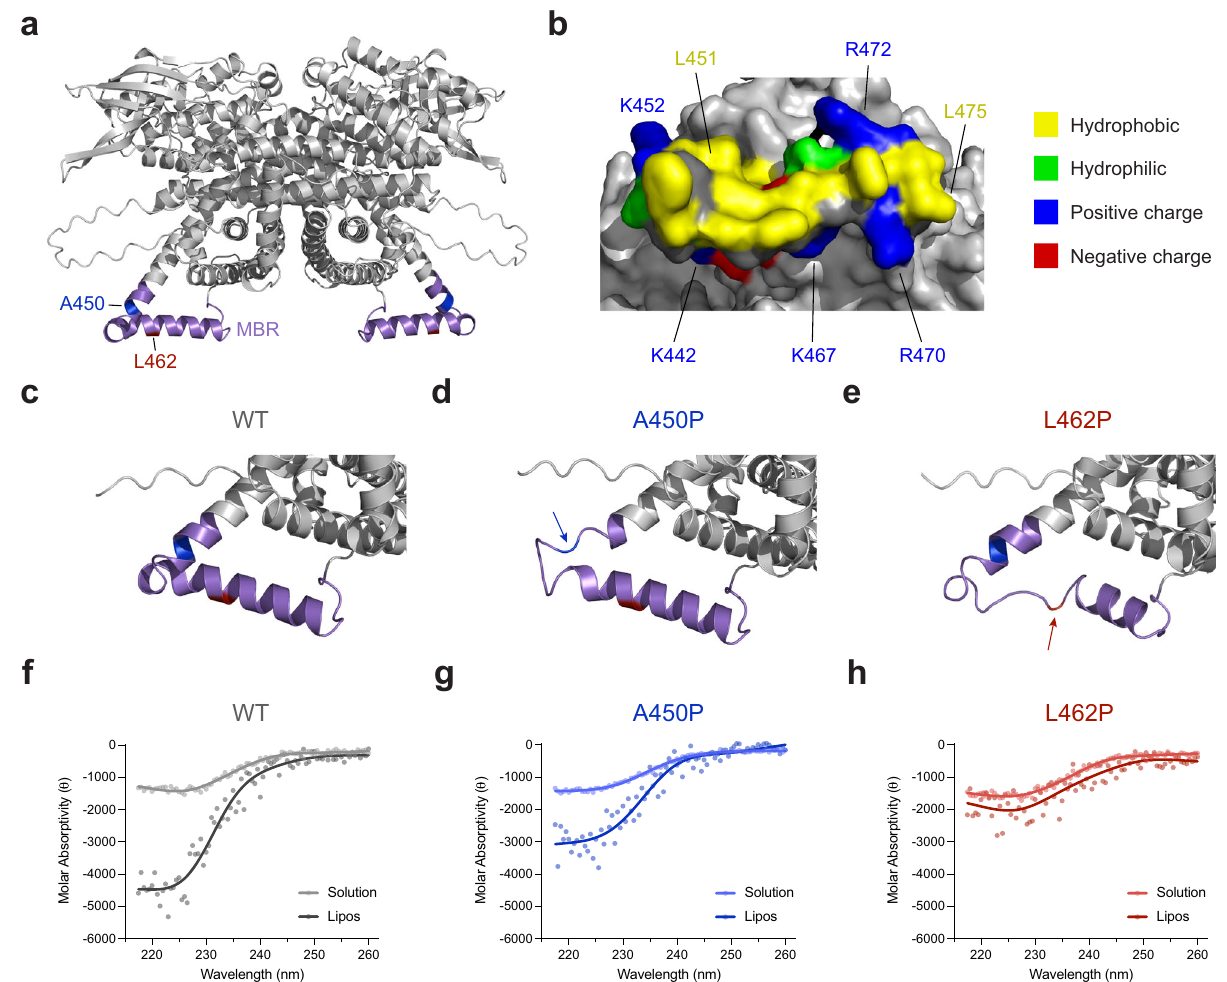
Fig. 4 Computational and circular dichroism analyses support a model for proline-mediated disruption of a membrane-interacting hairpin located within VLCAD ’ s C-terminal domain. a AlphaFold model structure of dimeric VLCAD demonstrating residues 440 – 473 as a helix-turn-helix hairpin. Residues A450 and L462, two sites of proline mutagenesis in human VLCAD de fi ciency, are colored in blue and red, respectively. b A surface view of the predicted α -helical hairpin demonstrates a hydrophobic interface surrounded by a perimeter of positively-charged residues, including lysines 440, 442, 452, 467 and arginines 470, 471, 472. c - e Model structures (AlphaFold) for wild-type ( c ), A450P ( d ), and L462P ( e ) VLCAD proteins demonstrate how proline mutagenesis can disrupt the structure of the α -helical hairpin. f - h Circular dichroism (CD) of wild-type ( f ), A450P ( g ), and L462P ( h ) peptides corresponding to residues 440 – 473 of the predicted α -helical hairpin in solution and in the presence of liposomes (relative α -helicity in the presence of liposomes of 2.5:1.7:1 for wild-type:A450P:L462P). CD experiments were performed in duplicate using independent preparations of peptides with similar